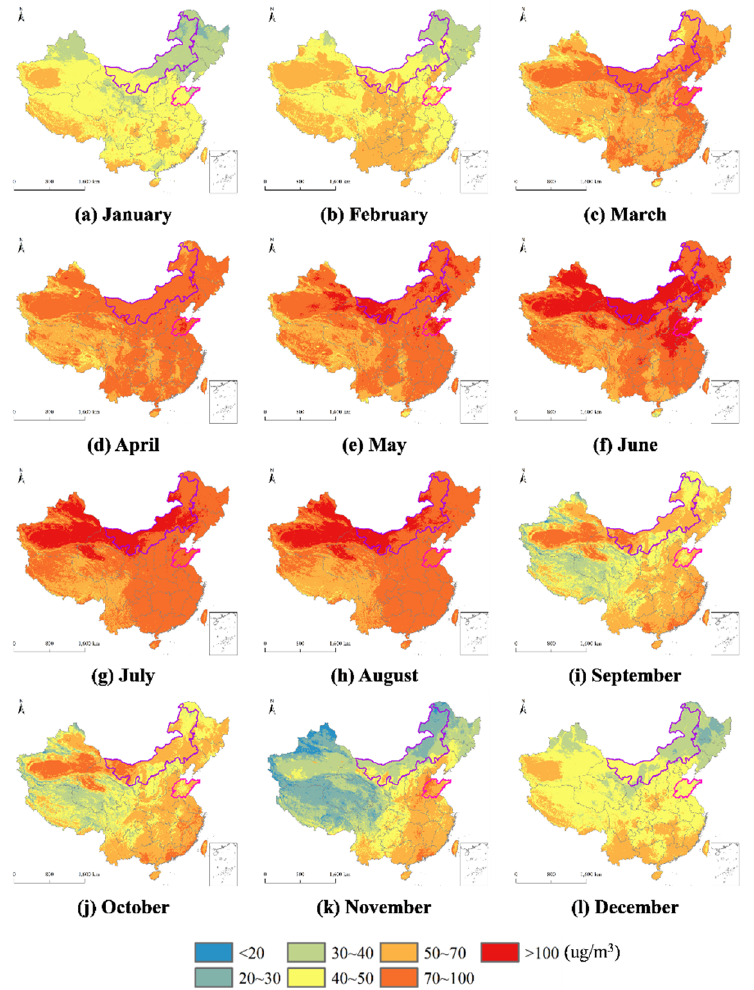
Figure 10. Nationwide monthly average GOCs at a 1 km spatial resolution in China in 2018 (purple box represents Inner Mongolia, pink box represents Shandong).